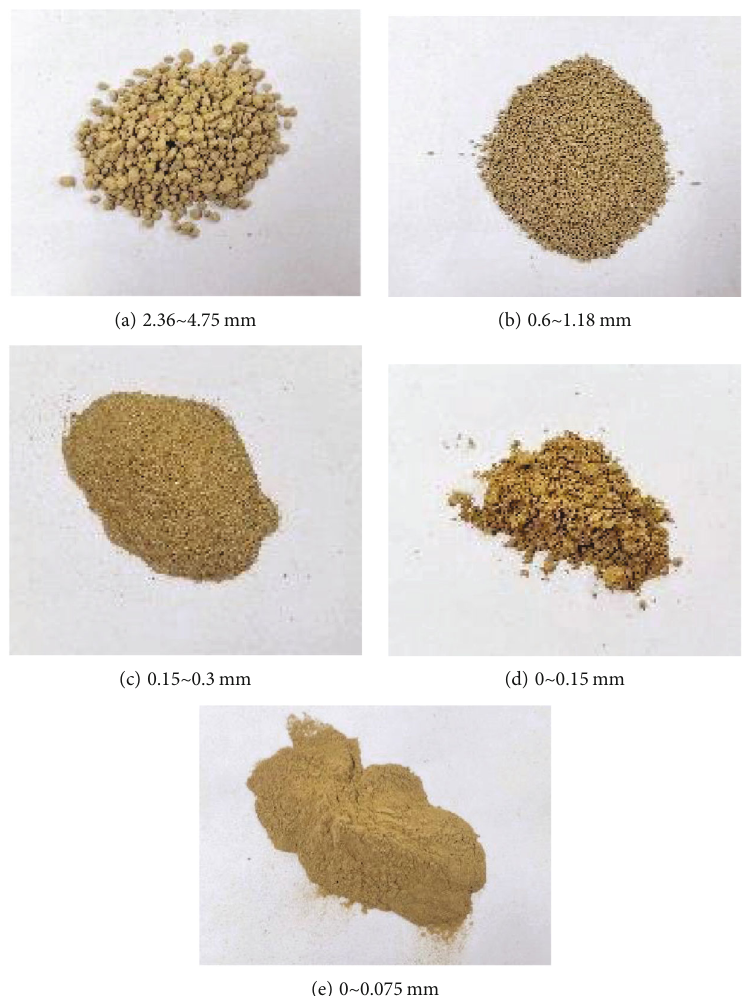
Figure 1: PAC waste residue of di ff erent particle